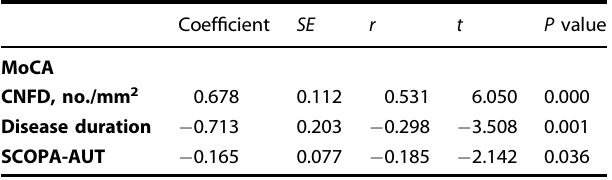
Table 2. Multiple linear regression analysis for cognitive function in Parkinson ’ s